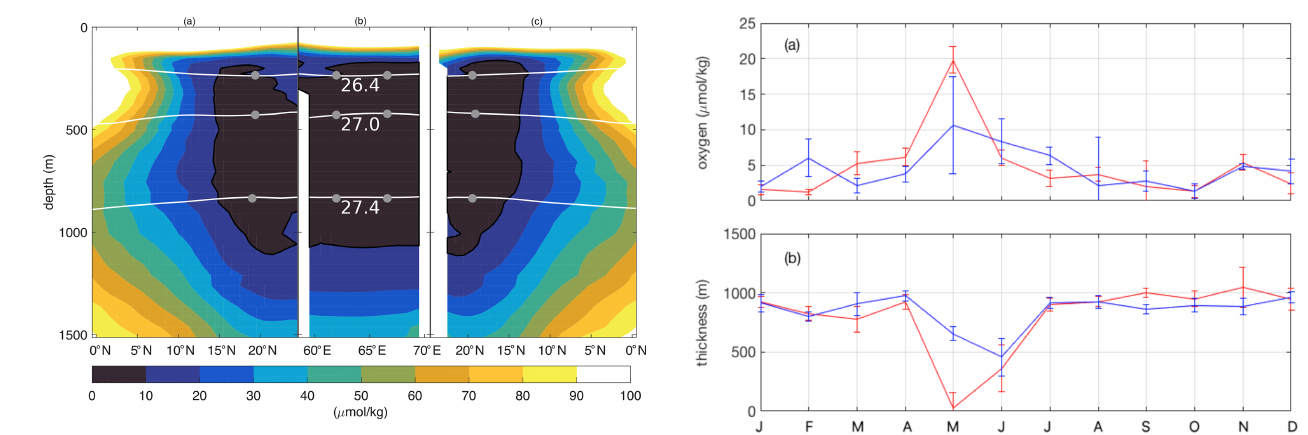
Figure 2. Annual mean dissolved oxygen concentration along 62 ◦ E (a) , 66.5 ◦ E (c) , and 19 ◦ N (b) from the WOA13 climatology (see Fig. 1). Advective pathways from Lagrangian particles are calcu- lated on three isopycnals (26.4, 27, 27.4kgm − 3 ) shown as white lines. The grey dots mark the release points in the western (WR) and eastern (ER) basin on each isopycnal level.